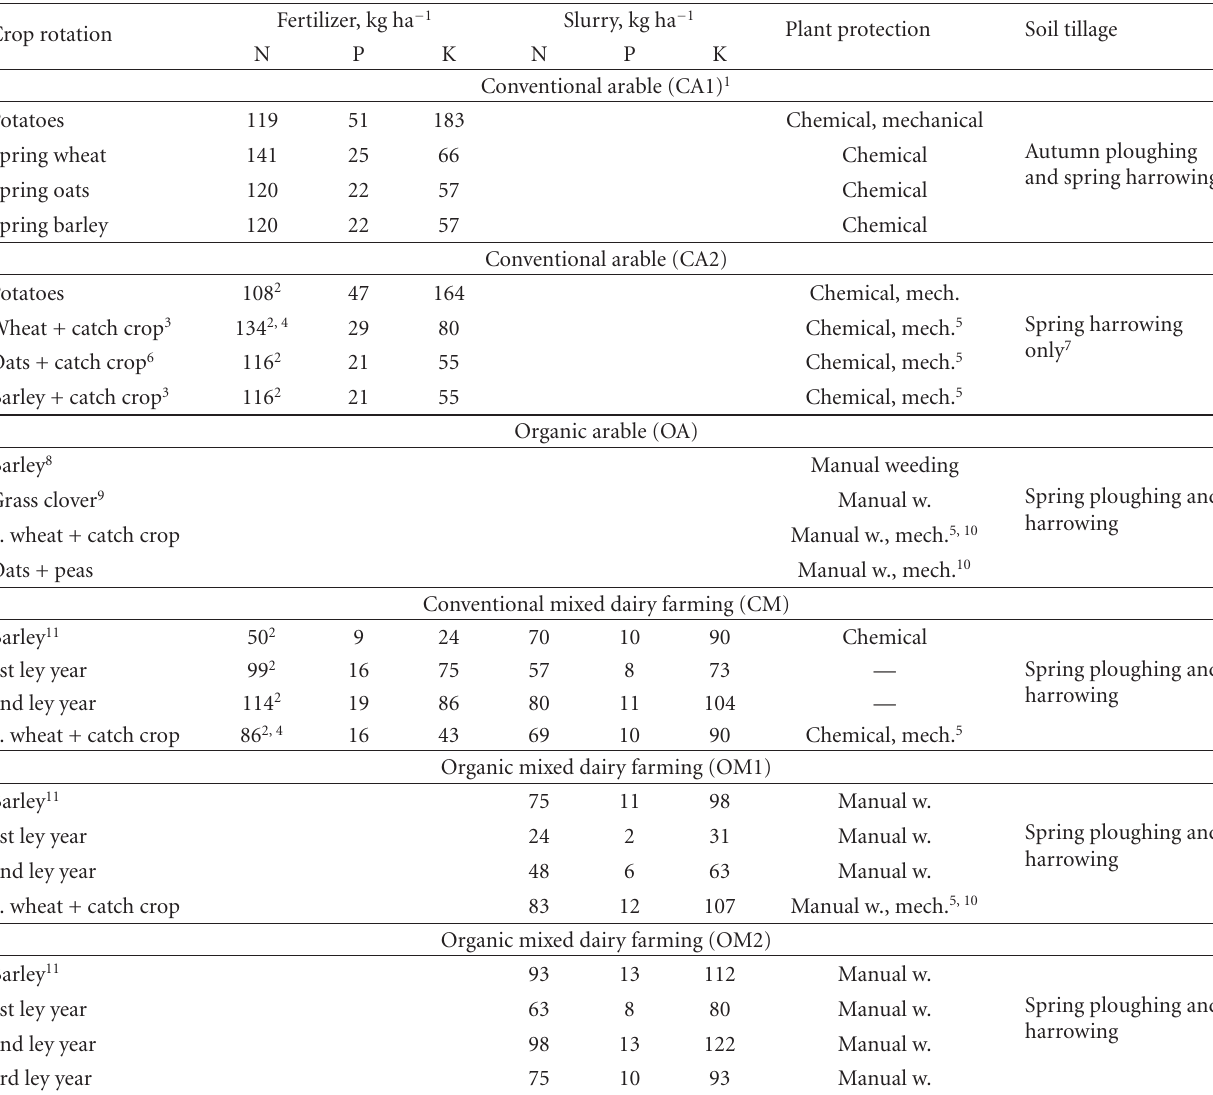
Table 2: Characteristics of the cropping systems at Apelsvoll,